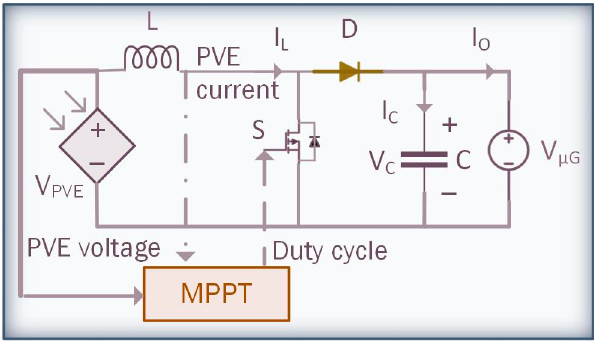
Figure 11. Maximum power point tracking (MPPT) control system diagram.